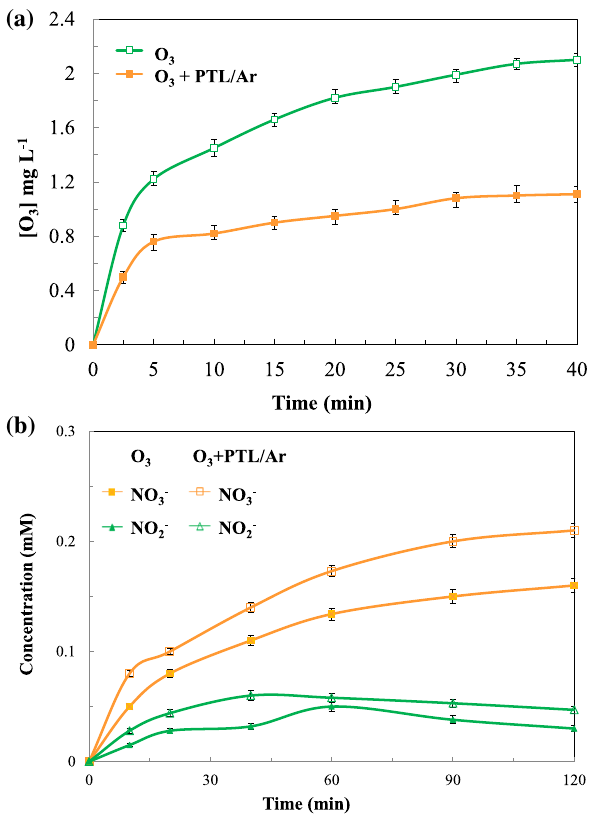
Figure 14. Dissolved ozone ( a ) and nitrogen evaluation ( b ) during ozonation and catalytic ozonation (PTL/Ar)